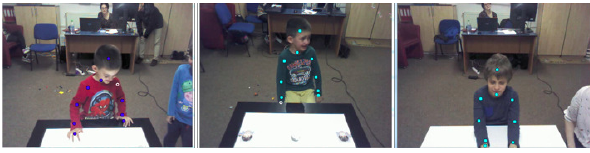
Figure 7: Skeleton joints detection for ASD